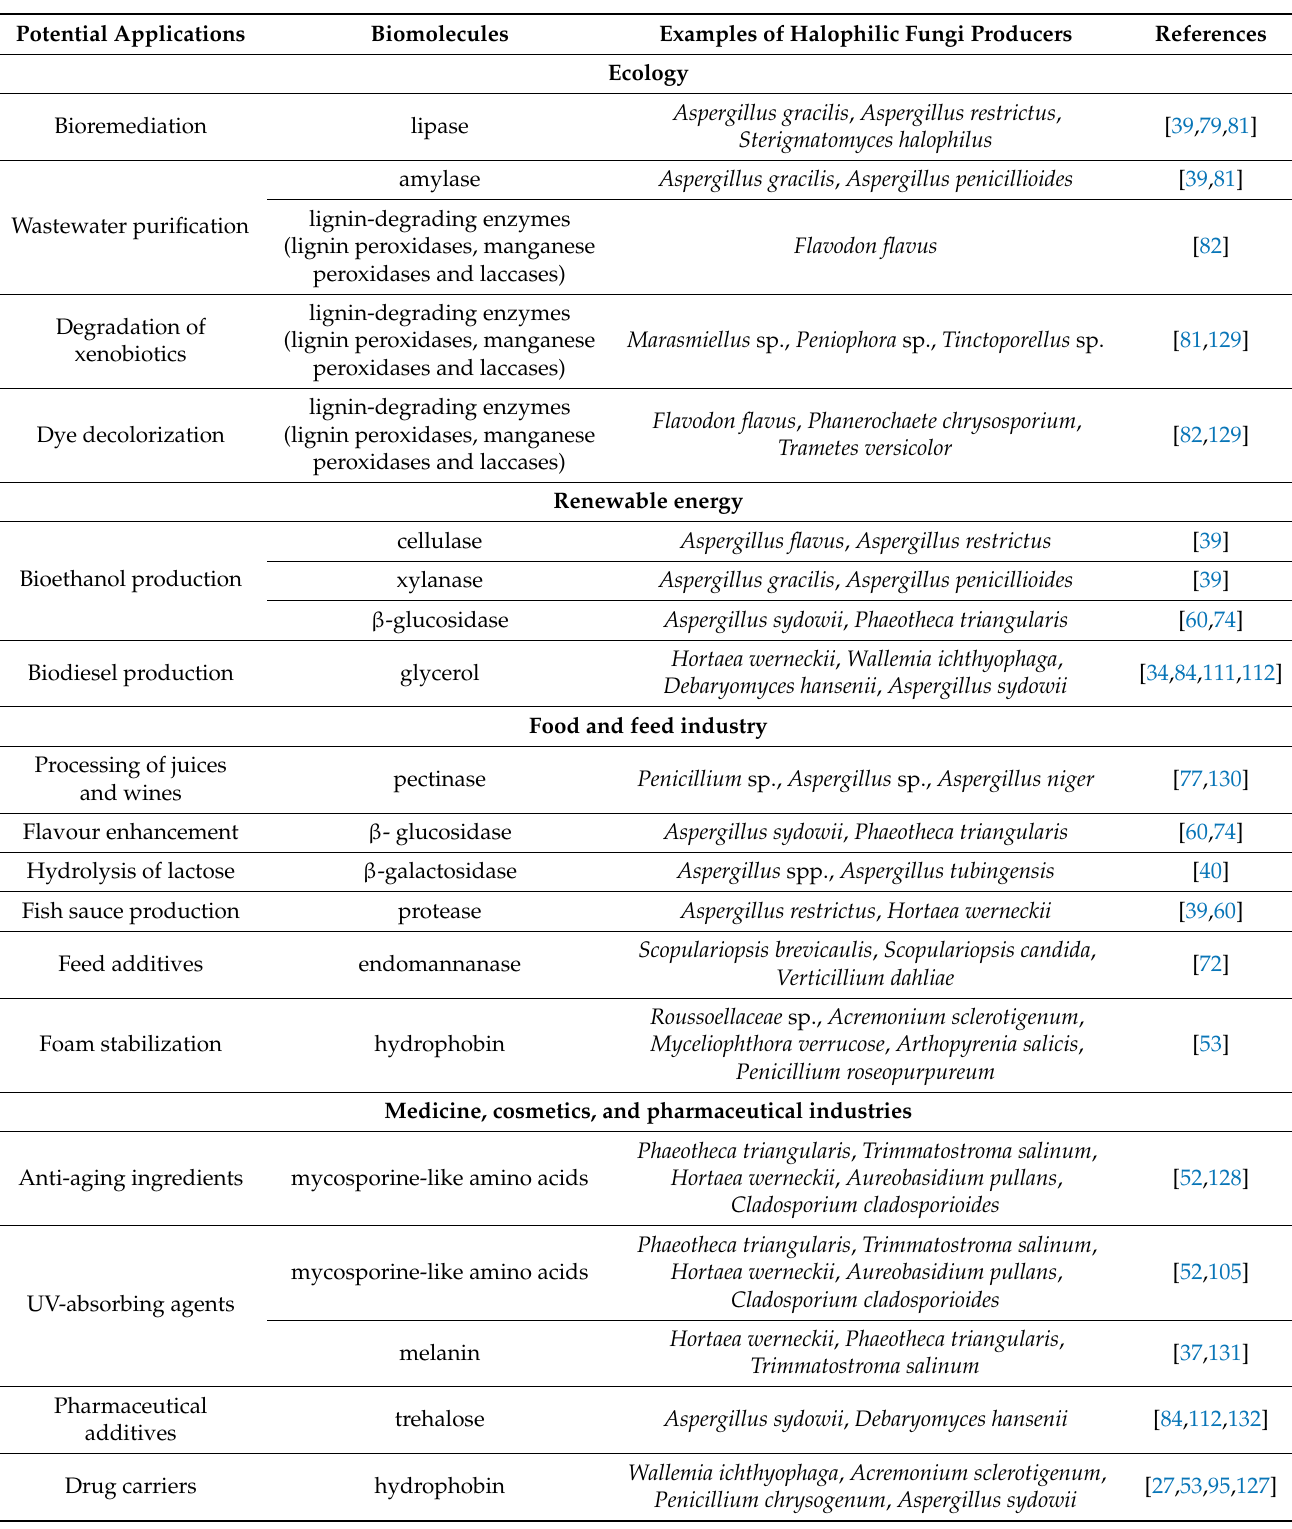
Table 6. Application of halophilic fungal